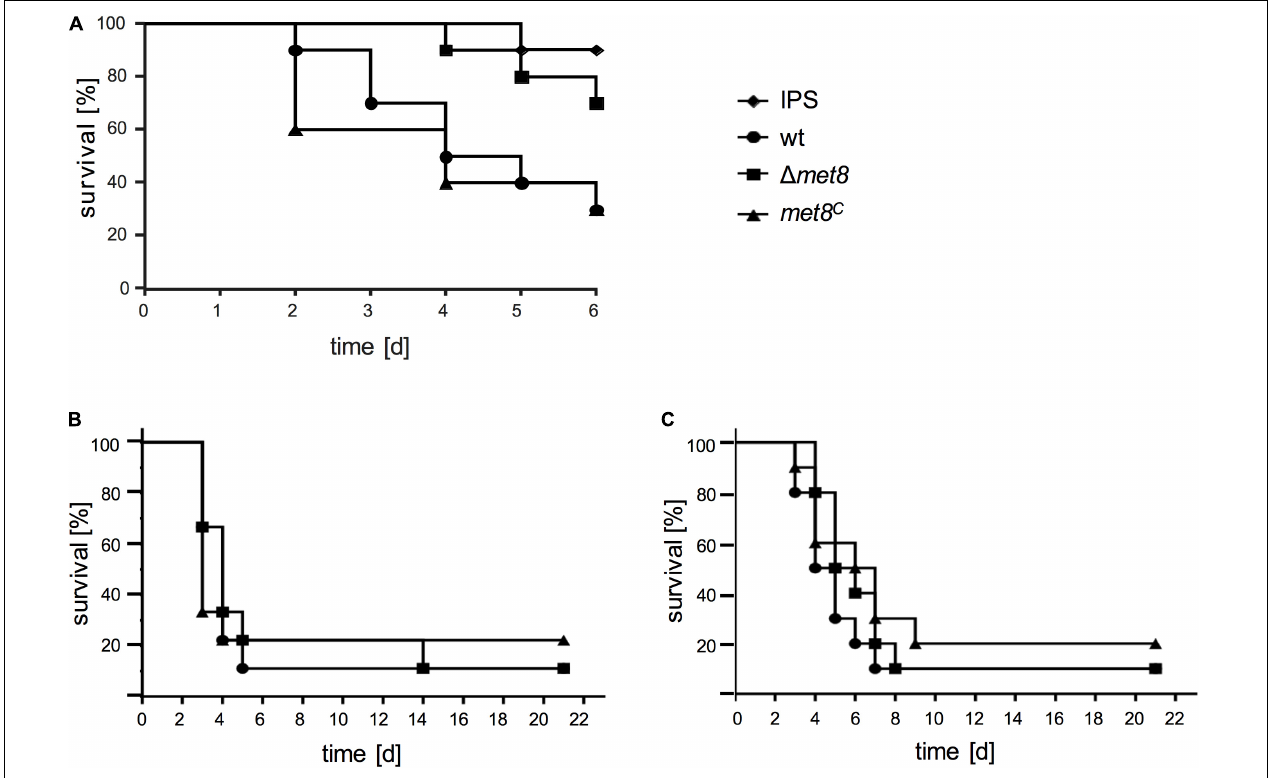
FIGURE 5 | Lack of Met8 affects virulence of A. fumigatus in the insect model Galleria mellonella (A) but not in murine models for invasive aspergillosis (B,C) . (A) G. mellonella larvae were infected with conidia of the wt, (cid:49) met8 and met8 C and survival was monitored over a period of 6 days. Control cohorts were injected with the conidial solution buffer (IPS). Met8-deficiency ( (cid:49) met8 ) attenuates virulence of A. fumigatus in G. mellonella compared to wt and met8 C strain ( P = 0.0365 vs. wt; P = 0.0258 vs. met8 C ). Survival curve for mice following intranasal infection of (B) cortisone-acetate immunocompromised mice (wt, n = 9; (cid:49) met8 , n = 9; met8 C , n = 9 animals/group) and (C) cyclophosphamide-immunocompromised neutropenic mice (wt, n = 10; (cid:49) met8 , n = 10; met8 C , n = 10 animals/group). Infection with (cid:49) met8 shows wt-like virulence in both murine